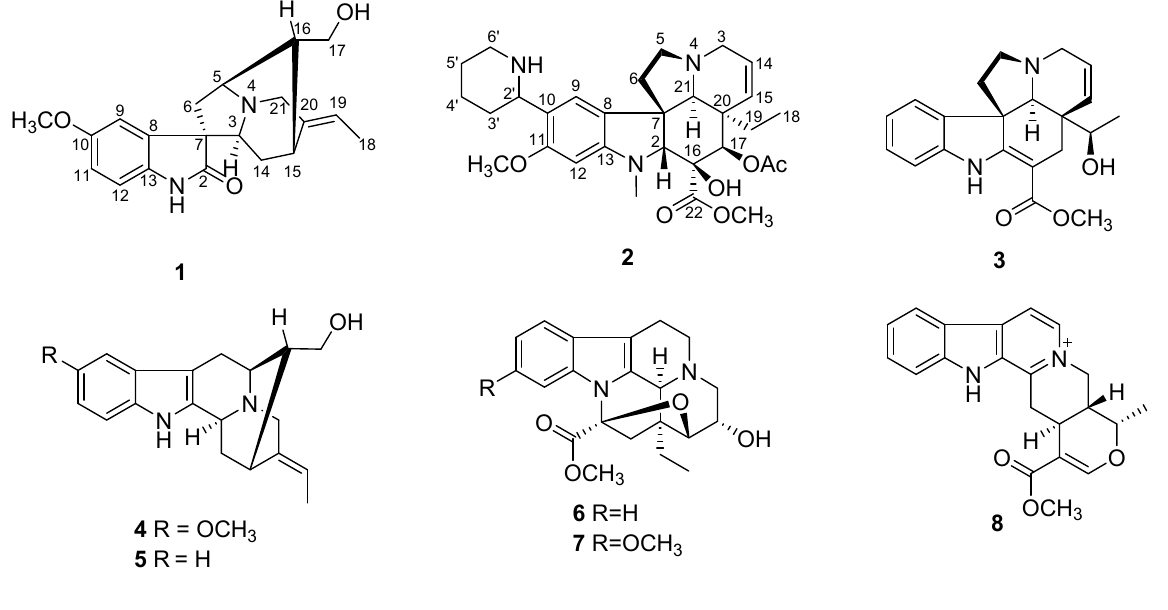
Figure 1. Structures of compounds 1 – 8 .